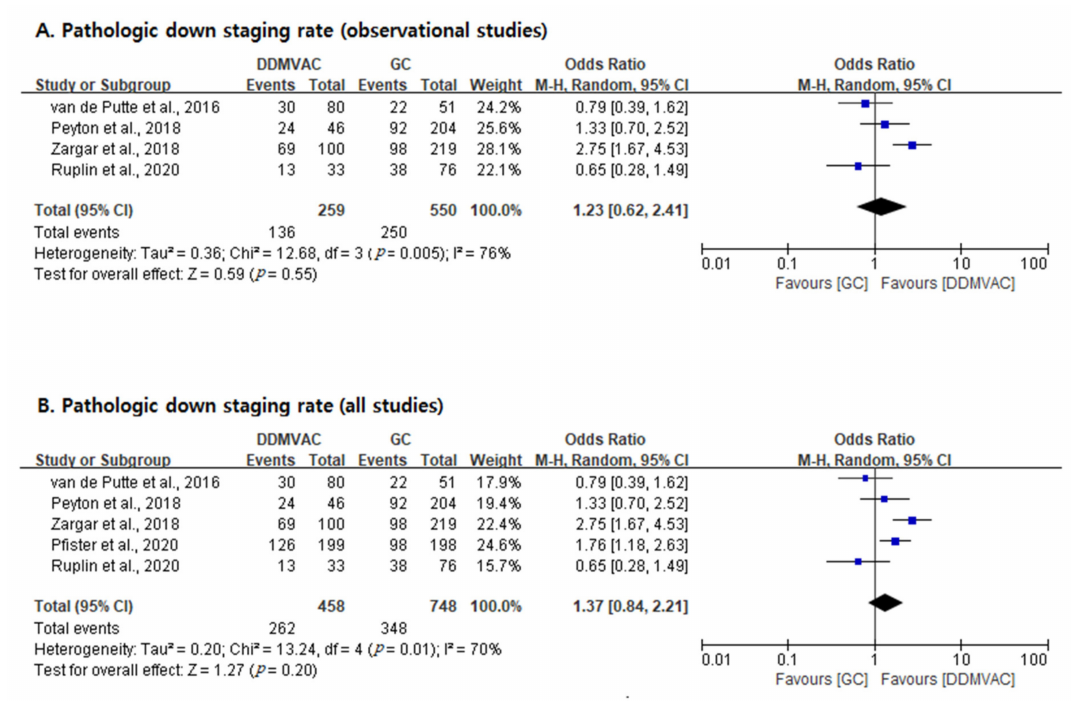
Figure 3. Forest plots of pathologic downstaging rates. ( A ): Observational studies only. ( B ): All studies.